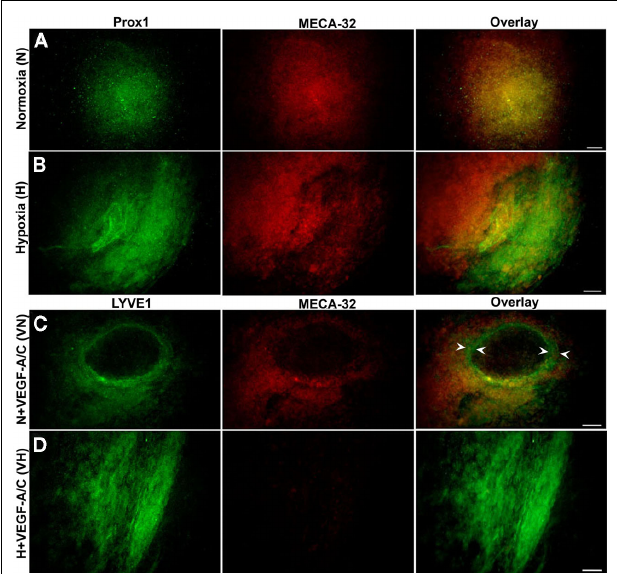
FIGURE 8 | E36.5-day-old EBs grown on laminin. EBs did not form vessel-like structures when stimulated under normoxic, hypoxic and VEGF-A/C environments. Representative data from three different experiments sets for each marker genes are shown. (A) Normoxic EBs grown on laminin did not show any distinguishable LEC phenotype, similar to those grown on collagen-I. (B) Hypoxic EBs did not induce any vessel-like structures within differentiating EBs. (C) N + VEGF-A/C EBs formed few ring-like structures (arrowheads) within the core of the EB and showed staining for LYVE1 in certain regions. (D) H + VEGF-A/C environments promoted LEC (LYVE1 + ) differentiation mostly on the periphery of differentiating EBs take. Images were en at 40 × magnification (scale bar 30 μ m).